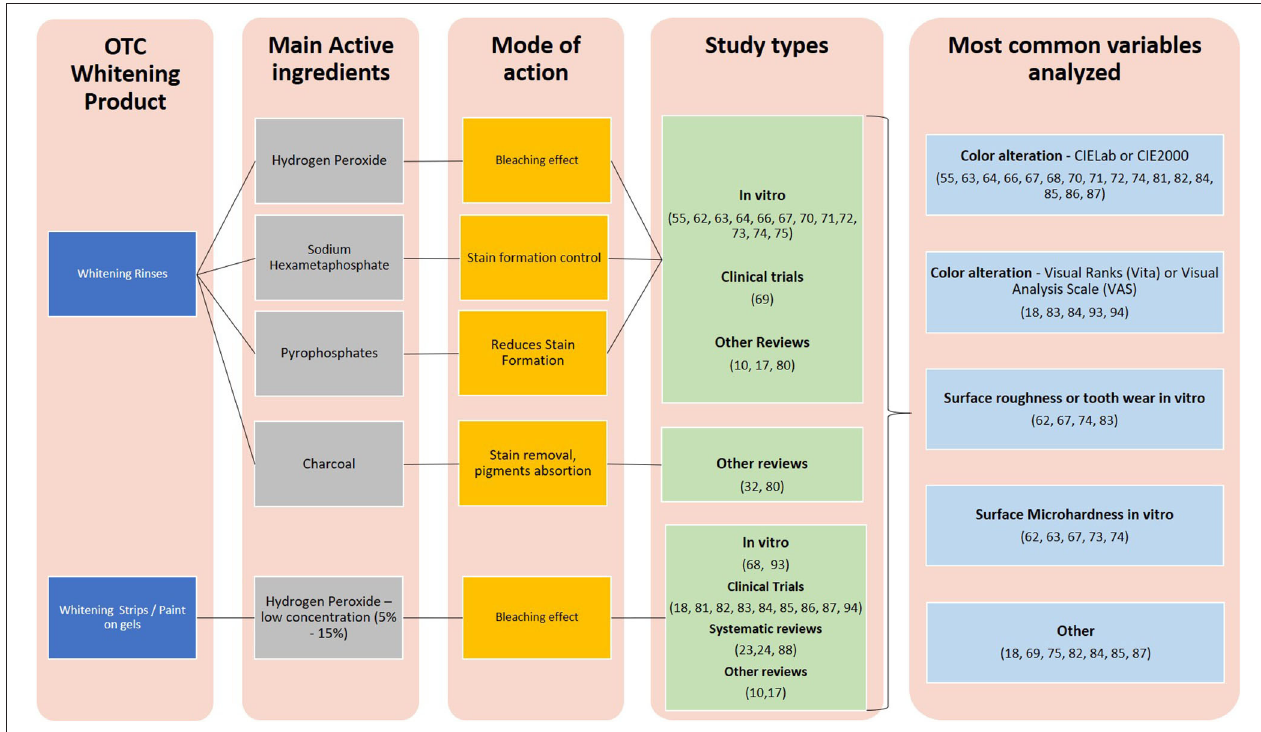
FIGURE 2 | Main findings from the evaluated studies considering whitening rinses and whitening strips (or paint-on gels) as OTC.